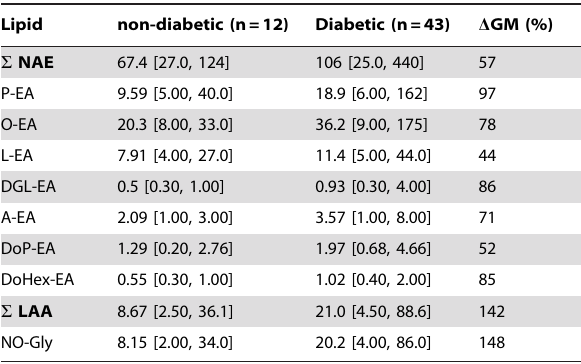
Table 4. Concentrations of selected plasma oxylipins (nM) in BMI-matched obese non-diabetic and type 2 diabetic African- American women.*.